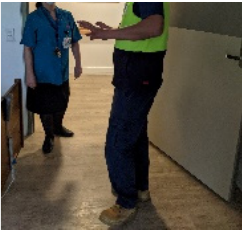
Figure 6. Staff in uniform.